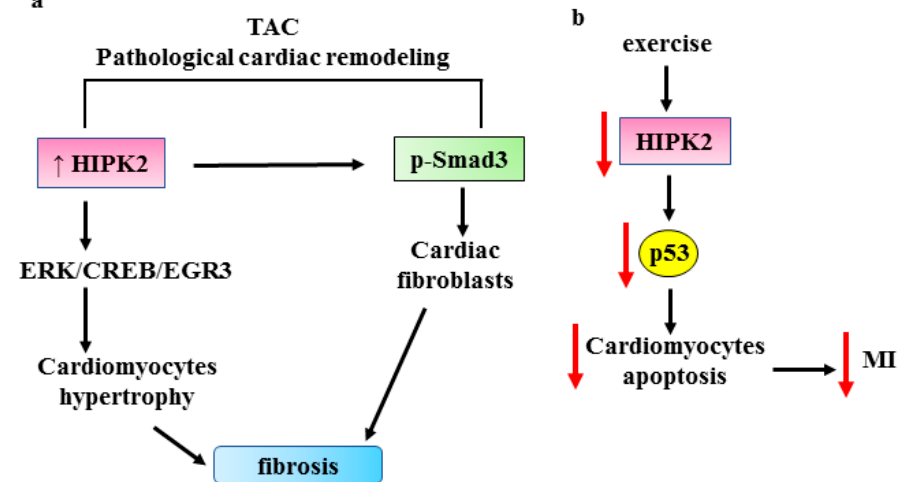
Figure 6. ( a ) Role for HIPK2 in cardiac fibrosis in a transverse aortic constriction (TAC) cardiac fibrosis model. The molecular pathways activated by HIPK2 are shown and they induce both cardiomyocyte hypertrophy and cardiac fibroblast proliferation, inducing cardiac fibrosis. ( b ) Schematic representation showing how exercise reduces myocardial infarction (MI) by downregulating HIPK2 with a consequent reduction in p53-induced cardiomyocyte apoptosis. Black arrows indicate activation. Red arrows indicate reduction/inhibition.